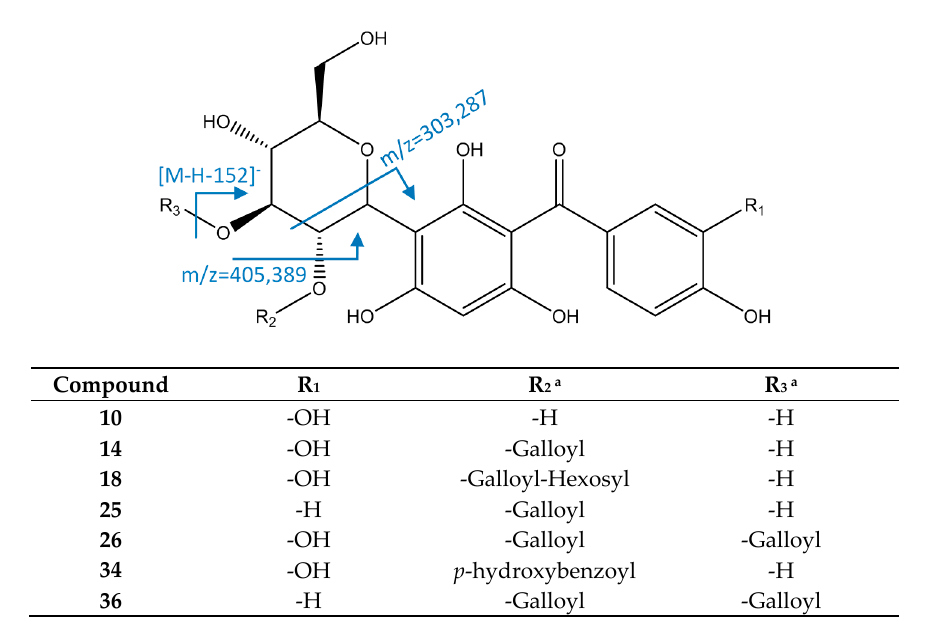
Figure 9. Structure and fragments of hydroxybenzophenones a Positions of substituents may vary among the hexoside ring.